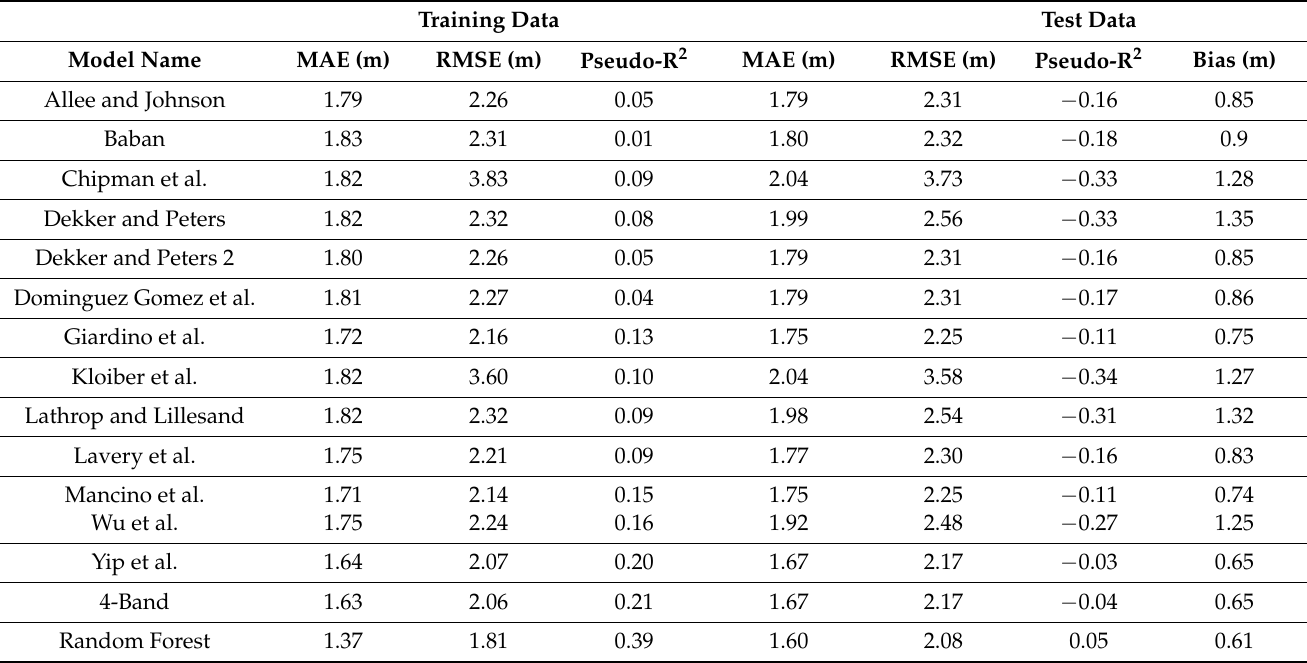
Figure 5. Training dataset model output for the overall dataset. Panels with a single asterisk (“*”) after the model indicate that there are values that are not displayed because there are negatively predicted Secchi. Panels with two asterisks (“**”) indicate that there are values that are not displayed because they are outside of the bounds of the limits displayed here (maximum Secchi depth displayed is 20m).